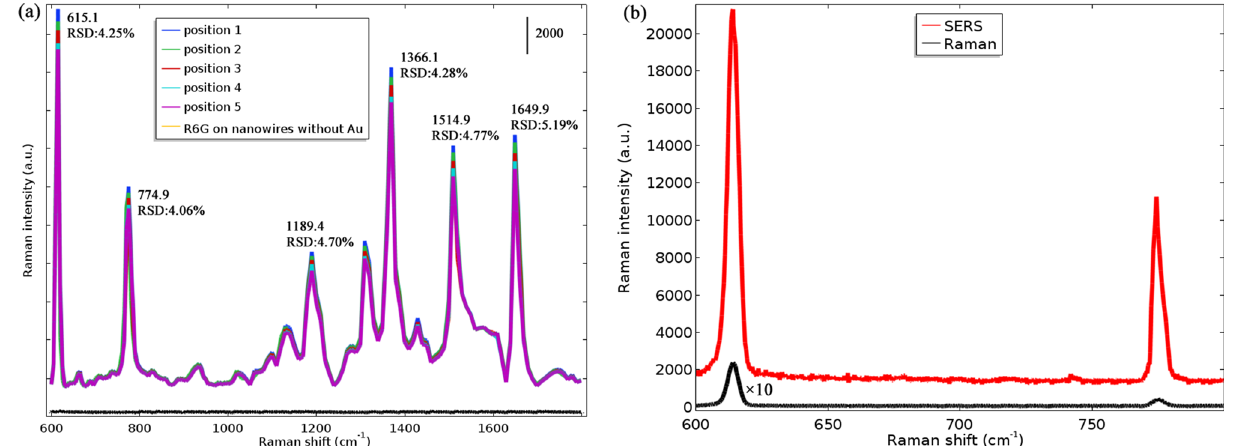
Figure 7. Raman and SERS spectra. ( a ) Measured Raman spectra of R6G (10 −6 M) molecules illuminated by 532 nm excitation wavelength collected from 5 randomly selected collection points, where RSD is relative standard deviation of Raman intensity at principal Raman peaks. ( b ) Comparison between the 615 cm −1